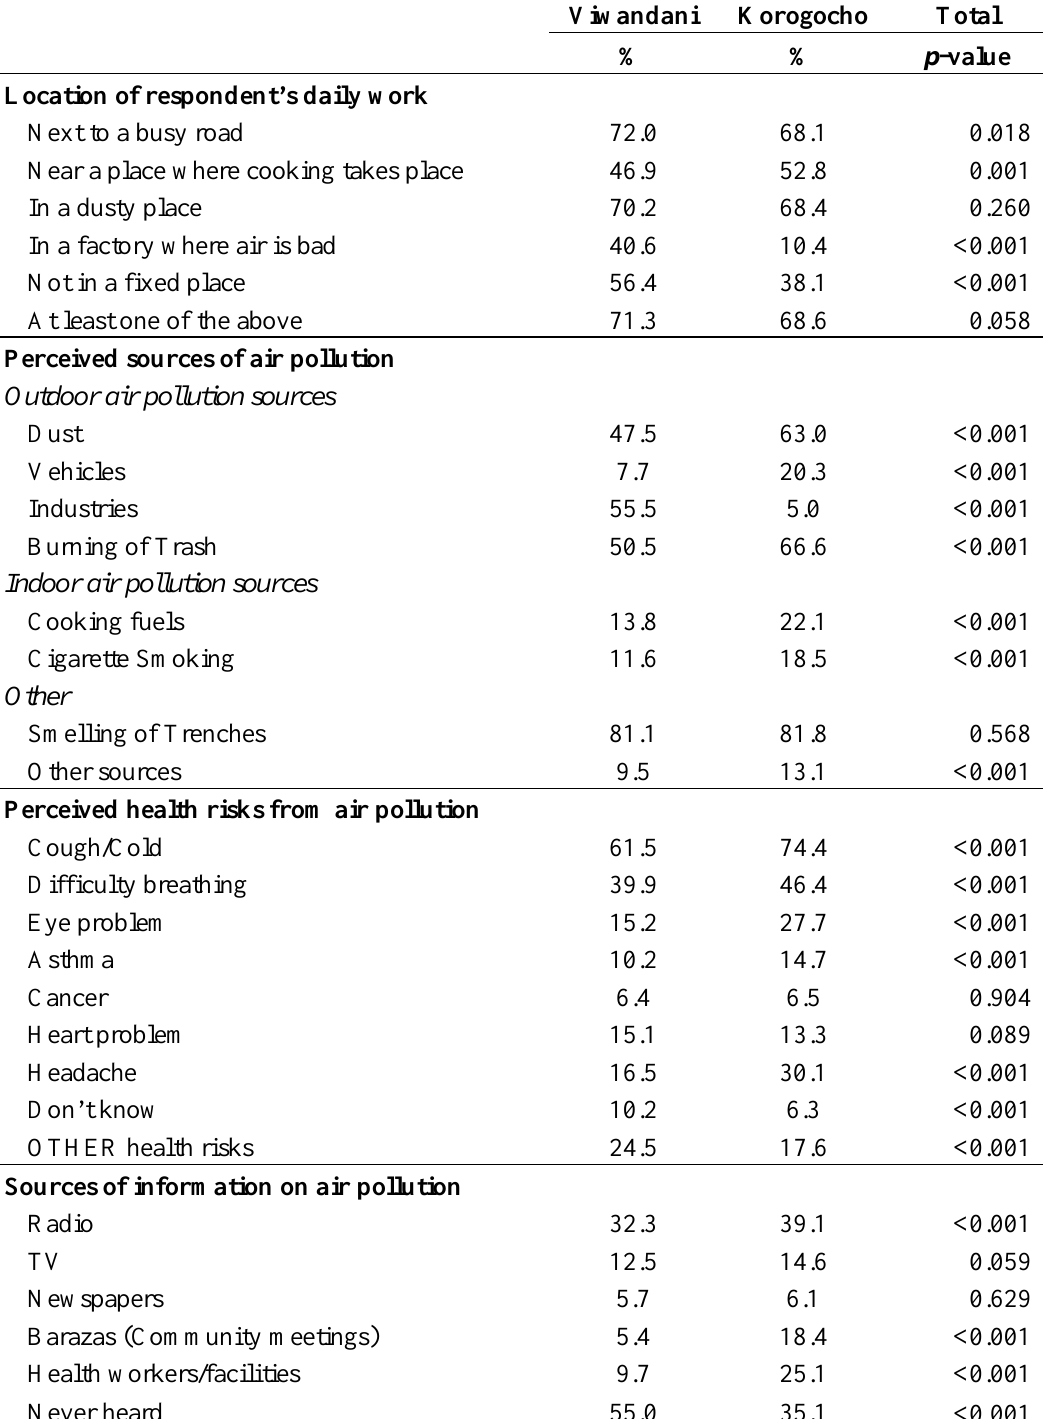
Table 3. The percentage distribution of respondents’ location of work, perceived sources of air pollution and health risks, and sources of information on air pollution by study